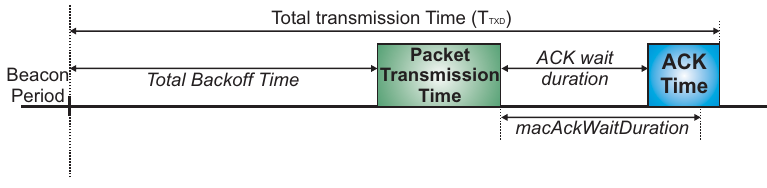
Figure 8. Transmission time duration of a data